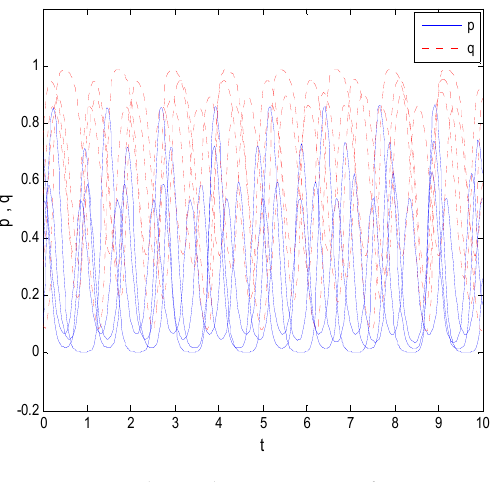
Figure 7. The evolution process of Case